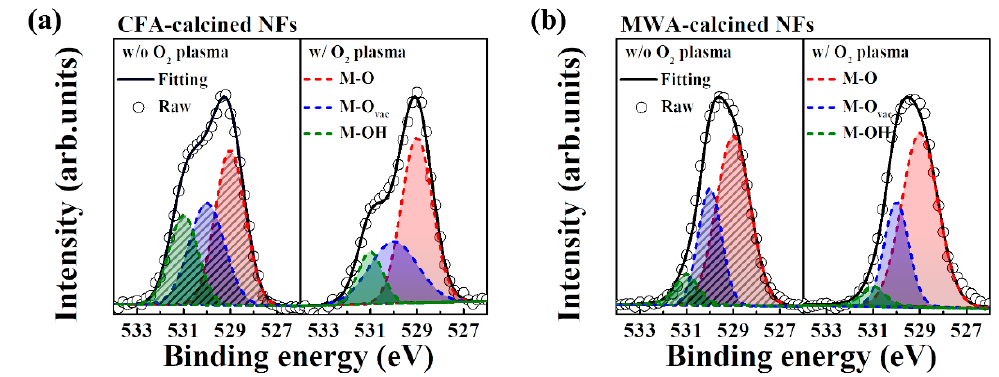
Figure 12. XPS O1s spectra of ( a ) CFA-calcined and ( b ) MWA-calcined IGZO NFs. Dashed and solid areas indicate data for IGZO NFs obtained before and after postcalcination oxygen plasma treatment, respectively.